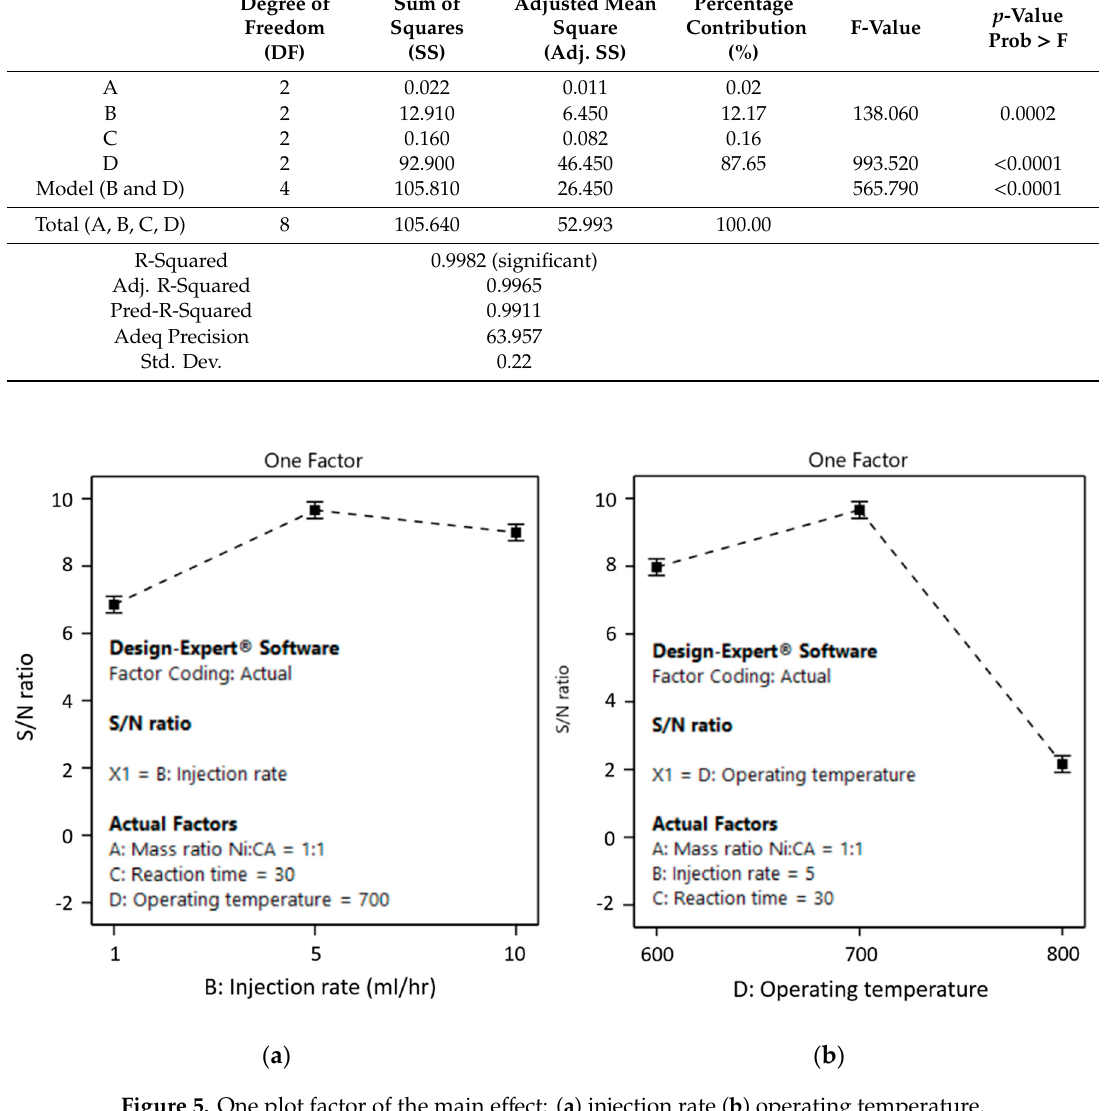
Figure 5. One plot factor of the main effect: ( a ) injection rate ( b ) operating temperature.